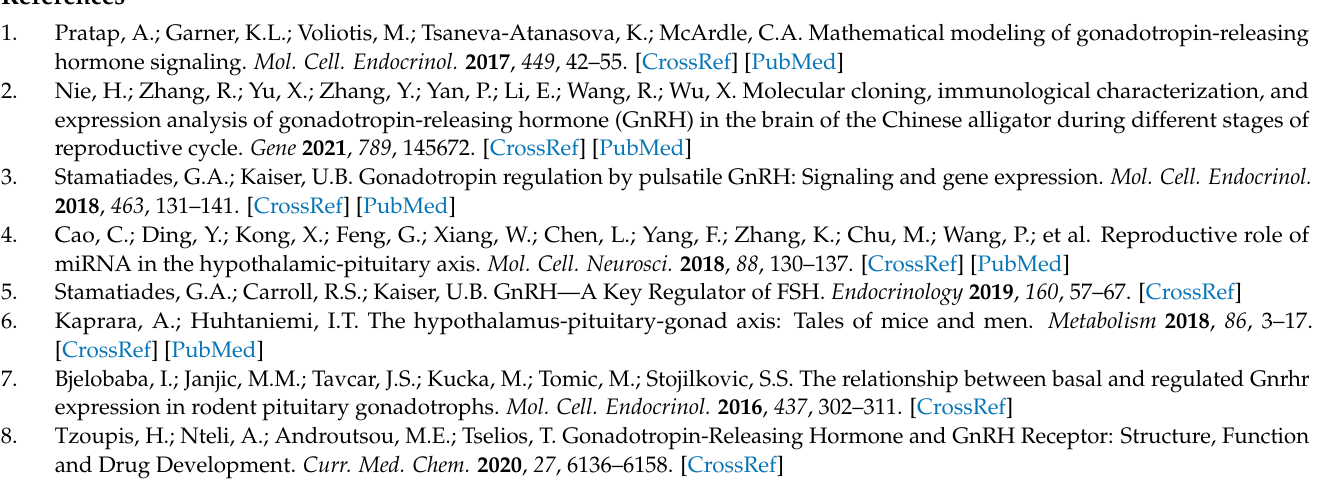
Table S3: L01_L02 circRNA, Table S4: L03_L04 circRNA, Table S5: All_gene_Length, Table S6: 01 mRNA location, Table S7: 01 circRNA location, Table S8: 02 mRNA location, Table S9: 02 circRNA location, Table S10: 03 mRNA location, Table S11: 03 circRNA location, Table S12: 04 mRNA loca- tion, Table S13: 04 circRNA location, Table S14: All.DEG.Expression, Table S15: L03_L04_vs_L01_ L02.GO, Table S16: L03_L04_vs_L01_L02.KEGG, Table S17: circRNA-miRNA net, Table S18: L03_L04_ vs_L01_L02.all.gene. Support File S1: